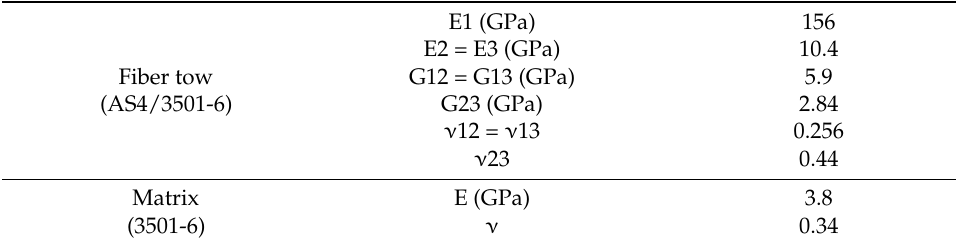
Table 2. Elastic properties.